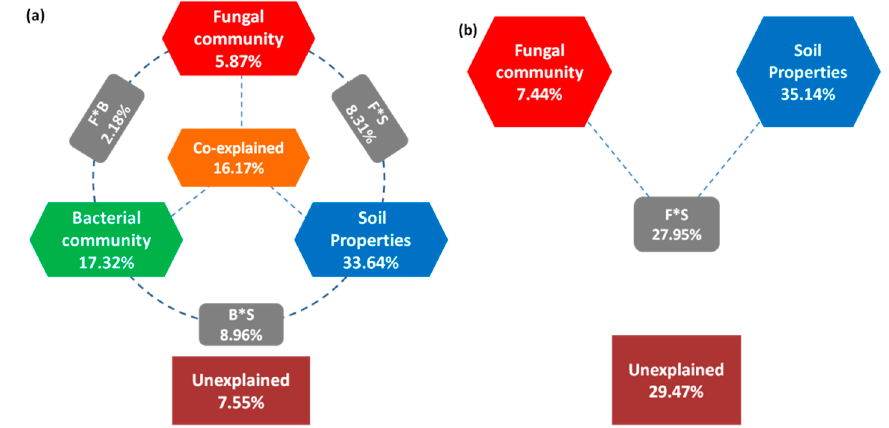
Figure 8. Variation partitioning analysis (VPA) of survival behavior of E. coli O157:H7 explained (%) by soil property, fungal community, and bacterial community ( a ) and soil property, fungal community ( b ).